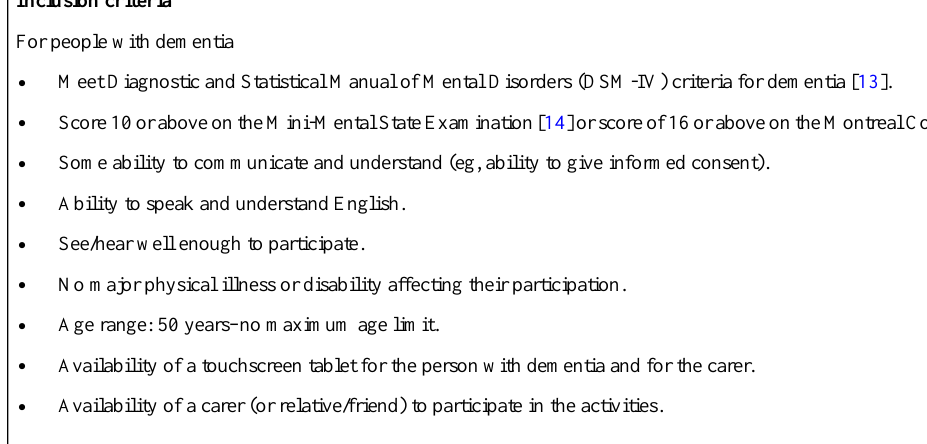
For people with